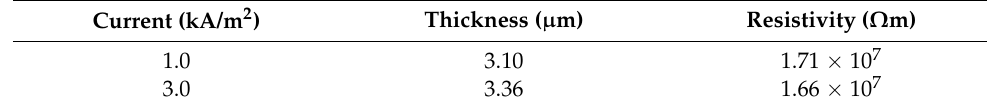
Figure 6. Voltage and PEO coating by CC operation. ( a ) Time variation of the voltages for a 400 s treatment time. ( b ) Cross-section and surface morphology of a PEO coating at a 60 s treatment time. Table 4. Thickness and resistivity of the PEO coating by CC operation.